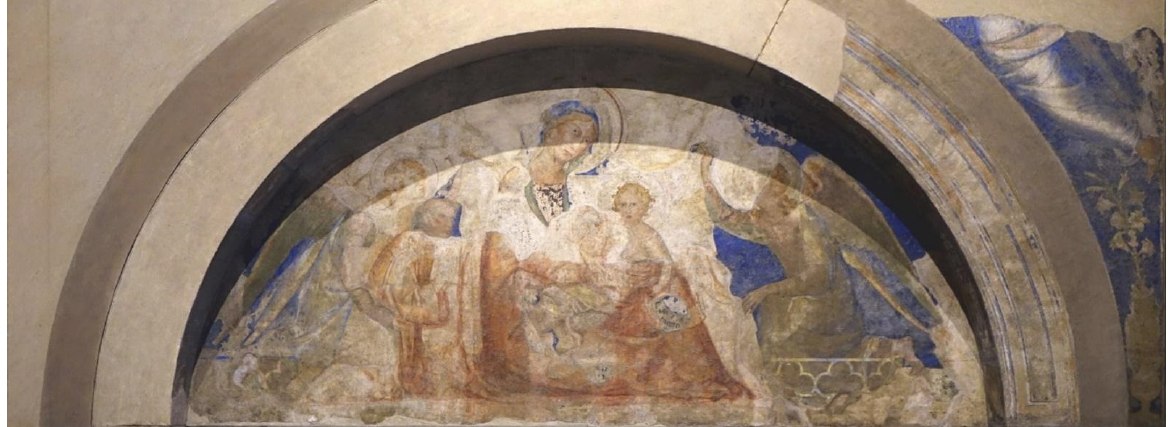
Figure 4. Virgin of Humility , Simone Martini, 1341, from Notre-Dame-des-Doms, papal palace of Avignon.